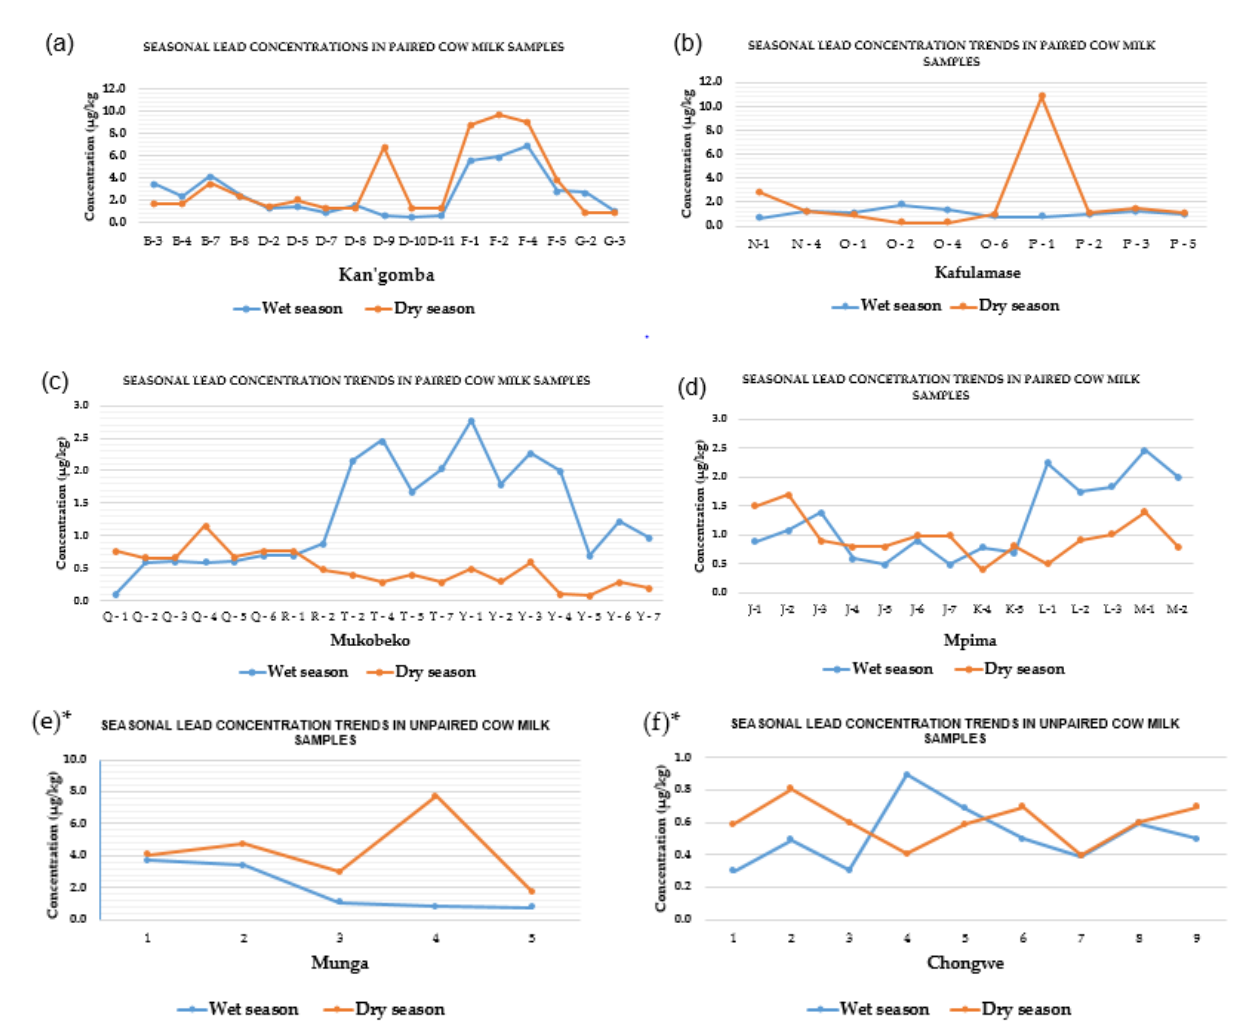
Figure 4. Pb concentration trends in paired cow milk samples collected in the wet and dry seasons in: ( a ) Kang’omba; ( b ) Kafulamase; ( c ) Mukobeko; ( d ) Mpima regions. Asterisk on ( e )* and ( f )* indicates unpaired milk samples, i.e., milk samples collected from different selected subjects in Munga and Chongwe regions during the wet and dry seasons. The letters on graph ( a – d ) represent identity numbers of paired samples from the same individual cows, while the numbers on graph ( e )* and ( f )* represent sample identity numbers for unpaired samples from different animals of the same herd.